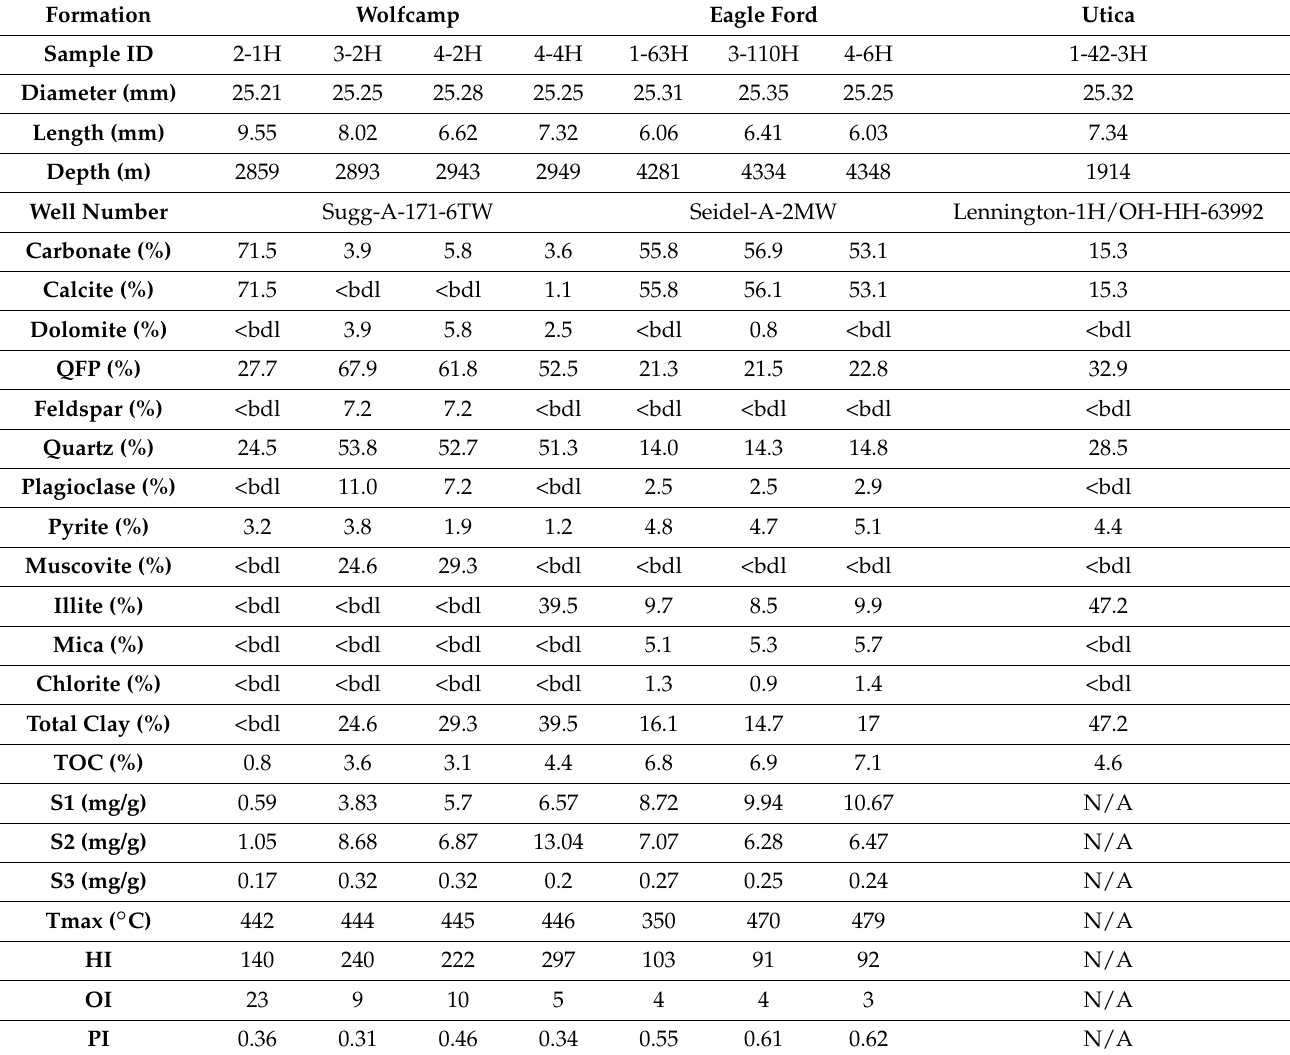
Table 1. Mineralogical content, depth, and RockEval analysis for the samples in this